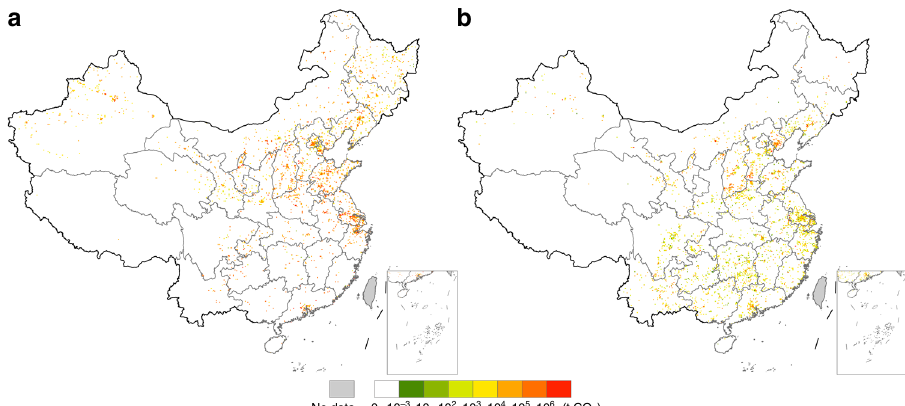
Fig. 4 Export-driven carbon footprint hotspots in two different sectors in China. a shows the carbon footprint hotspots driven by export in production and supply of electricity, steam, gas, and water sector, and b shows the carbon footprint hotspots driven by export in smelting and processing of metals